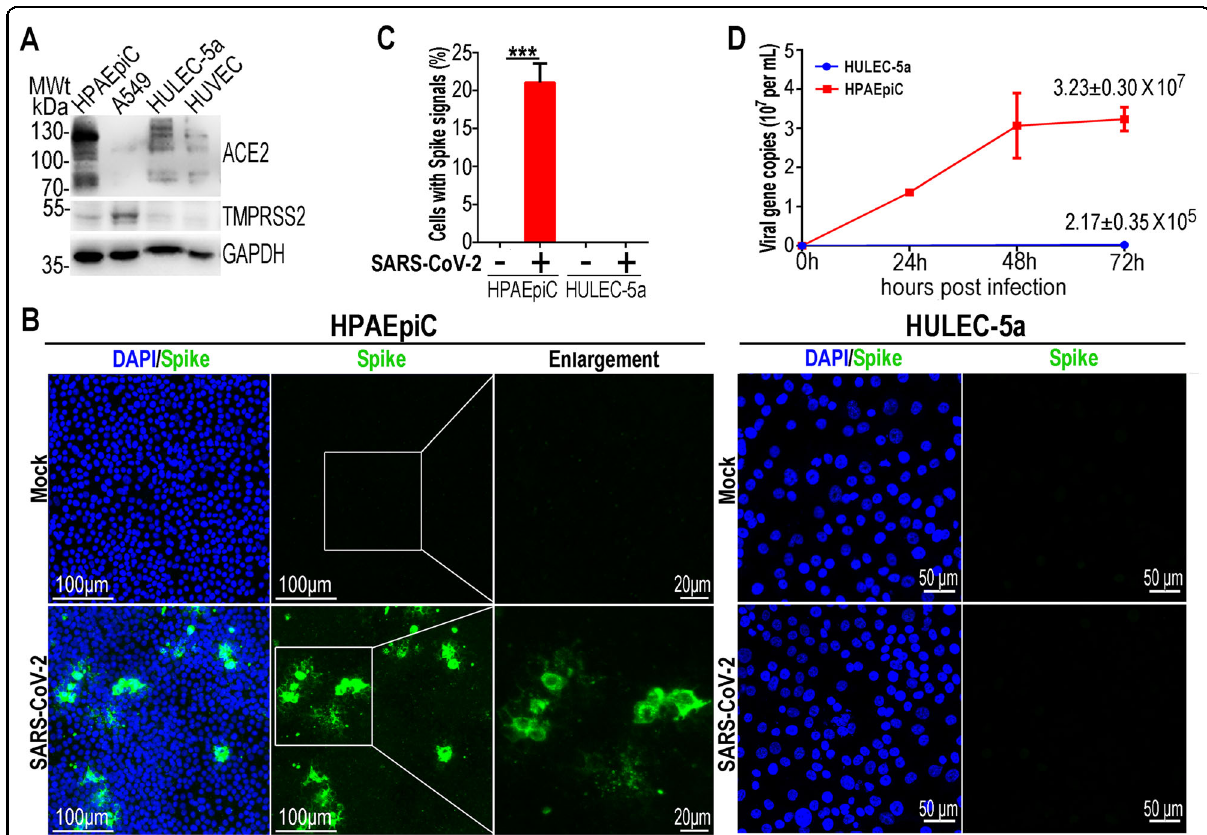
Fig. 1 HPAEpiC cells were more susceptible to SARS-CoV-2 infection than HULEC-5a cells. a Western blot was performed to analyze the expression level of ACE2 and TMPRSS2 in four cell lines. The result was a representative blot from three independent experiments. GAPDH was served as a loading control. b Confocal fl uorescent images of cells immunostained for viral Spike protein (viral Spike protein S1 subunit) 72 h post-infection. c Quanti fi cation of the percentage of HPAEpiC cells or HULEC-5a cells immunostained by viral Spike protein. Data represent four independent experiments, and more than 1000 cells for each group were quanti fi ed. Data were presented as mean ± SEM. Data were analyzed by Student ’ s t test (***: P < 0.001). d Culture supernatants of HPAEpiC cells or HULEC-5a cells were harvested at indicated time points following SARS-CoV-2 infection to examine the viral load using qRT-PCR for different groups. The average of two independent experiments was shown. Data were presented as mean ±